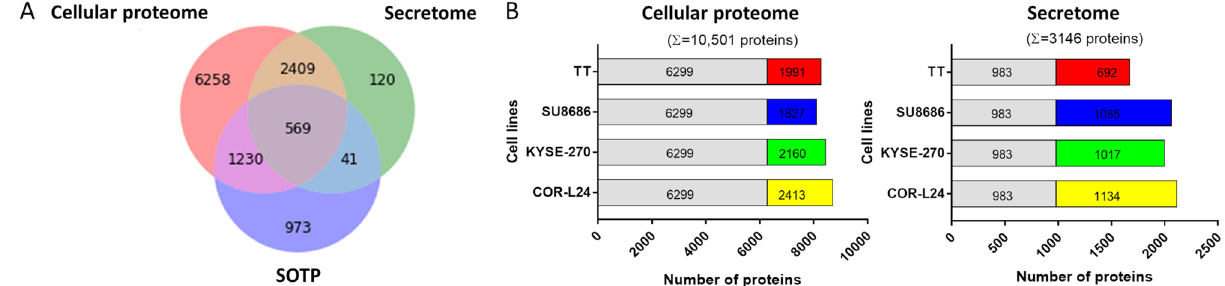
Figure 3. Deep proteomic analysis of selected cell lines. ( A ) Venn diagram of proteins quantified in cellular proteome and secretome compared to SOTP (gene centric). ( B ) Proportion of proteins quantified in all and contributions of different cell lines.